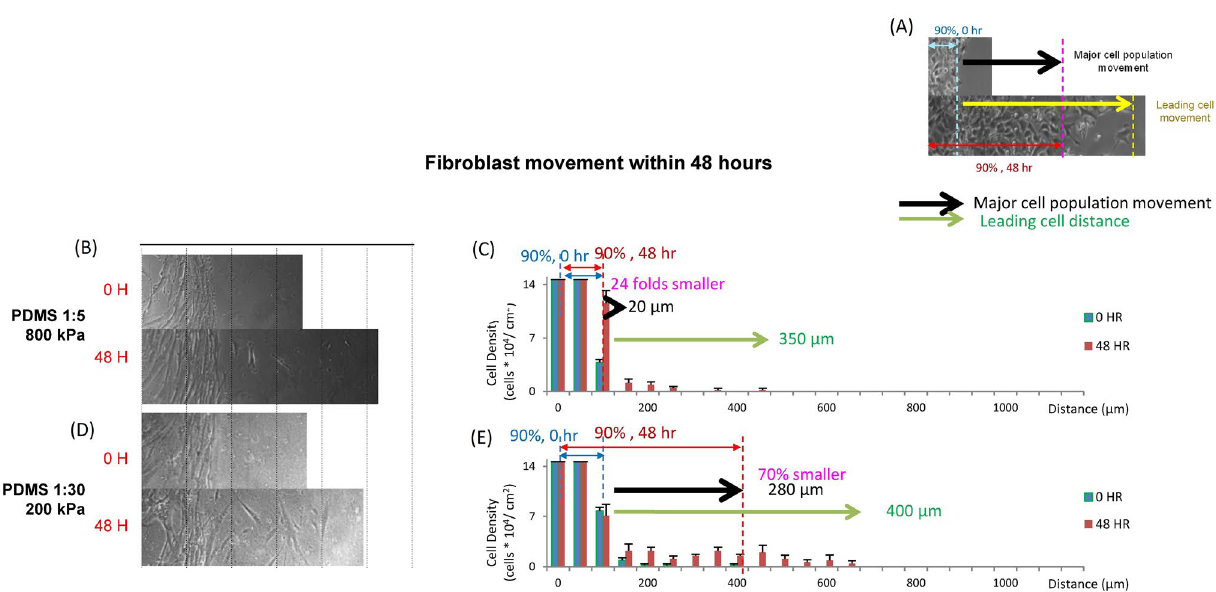
Figure 3. The motility of WI-38 fibroblast cells on fibronectin coated PDMS substrates with different stiffnesses. ( A ) A diagram to indicate “major cell population movement” and “leading cell distance”. Images and quantitation, respectively, of the movement of A549 epithelial cells attached on fibronectin coated PDMS substrates with stiffnesses including ( B , C ) 800 kPa and ( D , E ) 200 kPa at 0 h and 48 h after they were released. Data are standard deviation with total cell counts = 1470 and n =